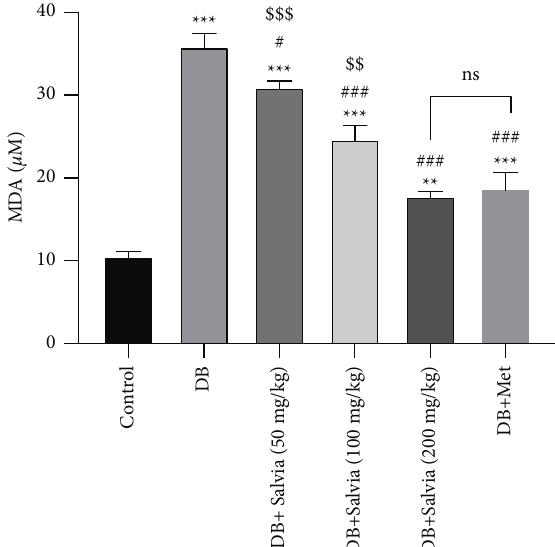
Figure 7: Effect of Salvia spinosa extracts on lipid peroxidation in the kidney tissue in streptozotocin-induced diabetic mice. Control: normal mice, DB: diabetic mice, DB +Salvia: diabetic mice given methanolic extract of Salvia spinosa , and DB+Met: diabetic mice given metformin (500 mg/kg). Values represented as mean ± SD. ∗∗∗ P < 0 . 001 compared with control mice. # P < 0 . 05 compared with diabetic mice. ## P < 0 . 01 compared with diabetic mice. ### P < 0 . 001 compared with diabetic mice. $$ P < 0 . 01 compared with metformin-treated diabetic mice. $$$ P < 0 . 05 compared with metformin-treated diabetic mice. Ns: nonsignificant.